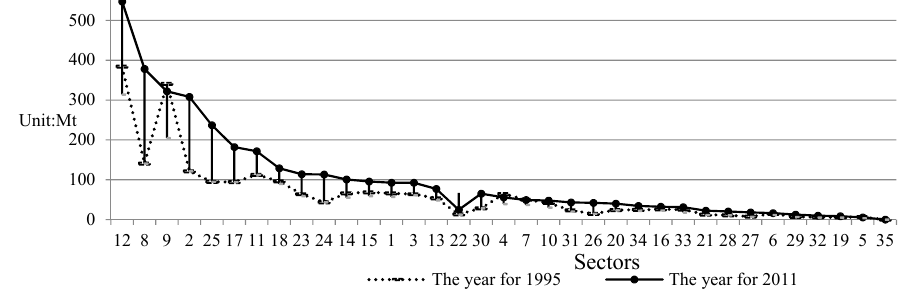
Figure 1. Changes of GHGs transferring via trade from 1995 to 2011 at a sector level. Notes: The maximum value and minimum value of GHGs embodied in trade in the corresponding sector between 1995 and 2011 are represented by the highest point and lowest point of the vertical line in the Figure 1, respectively. Table 1 presents the code of each sector in this